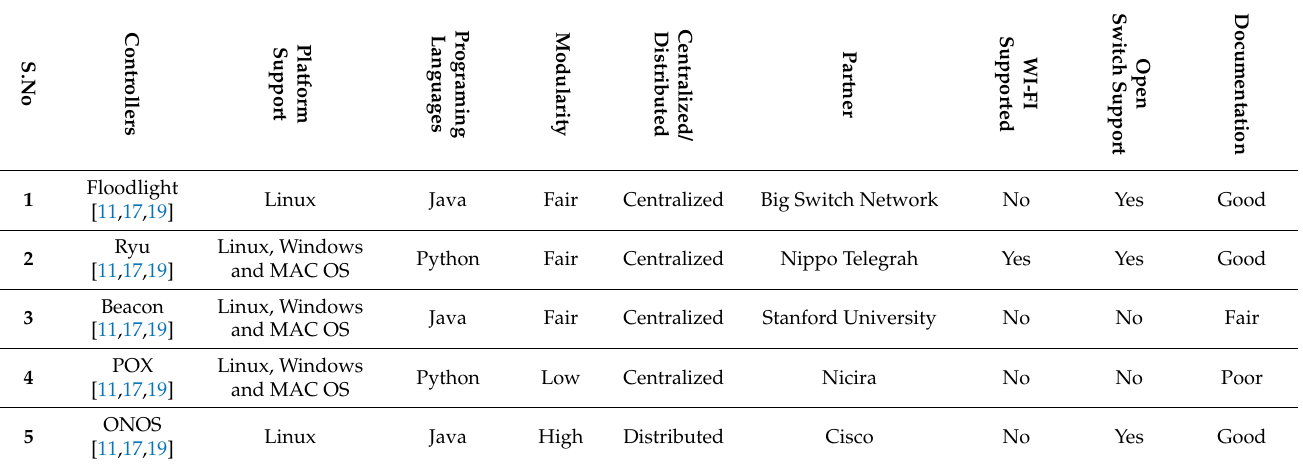
Table 1. Comparison of SDN